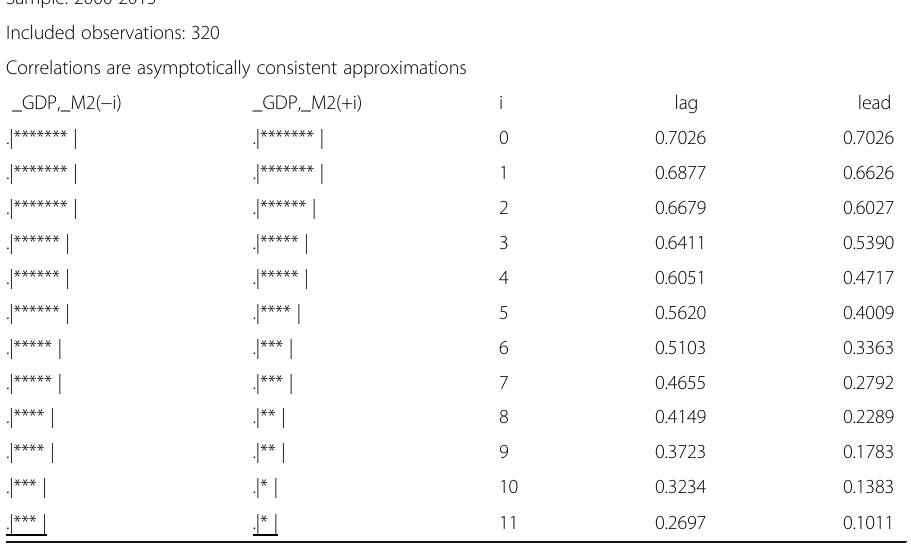
Table 15 Panel VAR Causality Lag Correlation Test